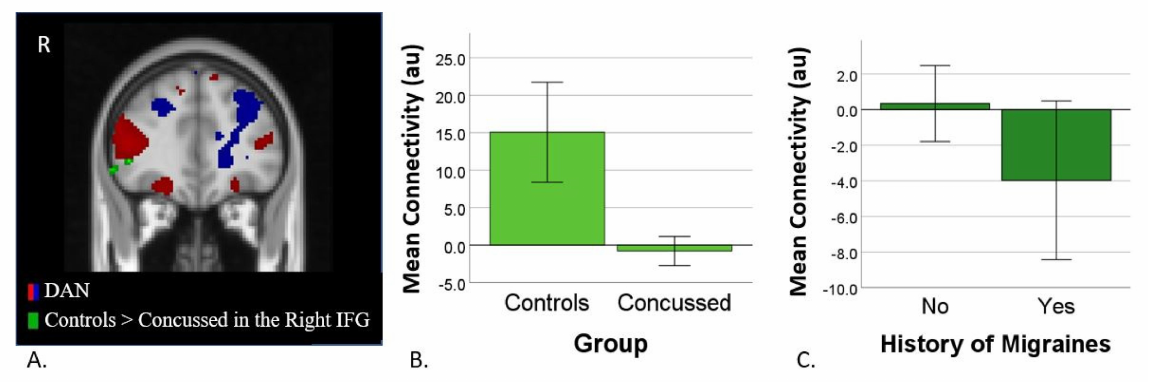
Figure 2. ( A ) Independent component (IC 7, red & blue) and region (RIFG) in which there is a significant difference in connectivity between control and concussed participants (green). ( B ) Bar graph illustrating mean parameter estimates in arbitrary units for the DAN-RIFG connectivity in control and concussed adolescents. ( C ) Bar graph illustrating mean DAN-RIFG connectivity for concussed participants with a history of migraine vs. those